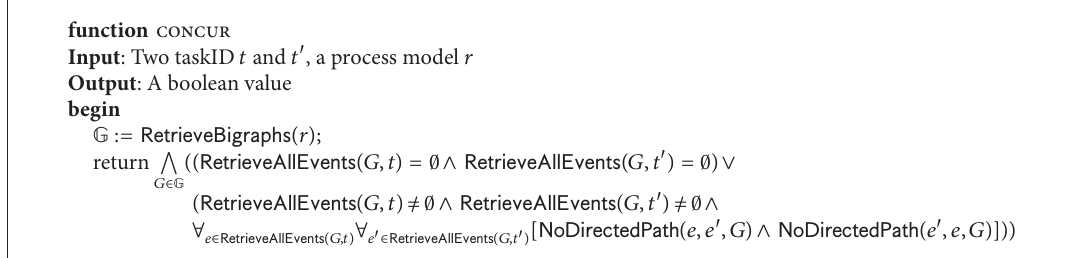
Algorithm 9: Determining the basic predicate concur .